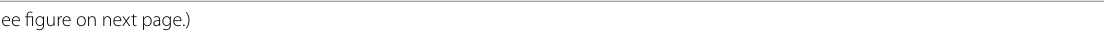
Topography(See figure on next Fig. 1 Hillshade of the bathymetric map of Lake Thun and the sourrounding area. a Map of the study area showing the location of the airgun (black lines) and the pinger (red lines) reflection seismic lines and the position of the long sediment core (white star). Bold lines represent the reflection seismic profiles that are shown in Figs. 3, 4 and 5. The black triangle shows the slide impact location for the simulation of the impulse wave. A, B, C and D refer to the locations where wave run-up has been estimated. b Enlargement of the detachment area on land and the depositional area of the mass movement in the lake. The dashed white line marks the the deformation lobe (“amphitheatre”). c Lake bottom profile of the X–Y transect (position is shown with a white line in b ). Source of the terrestrial digital elevation model: Swisstopo, Federal Office of